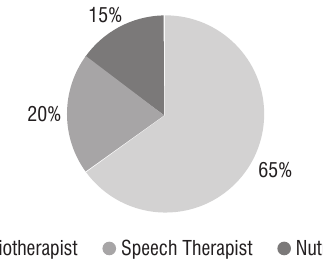
Figure 1 - Percentage of first assistance to stroke patients categorized by NASF professional according to the medical records at primary healthcare center.